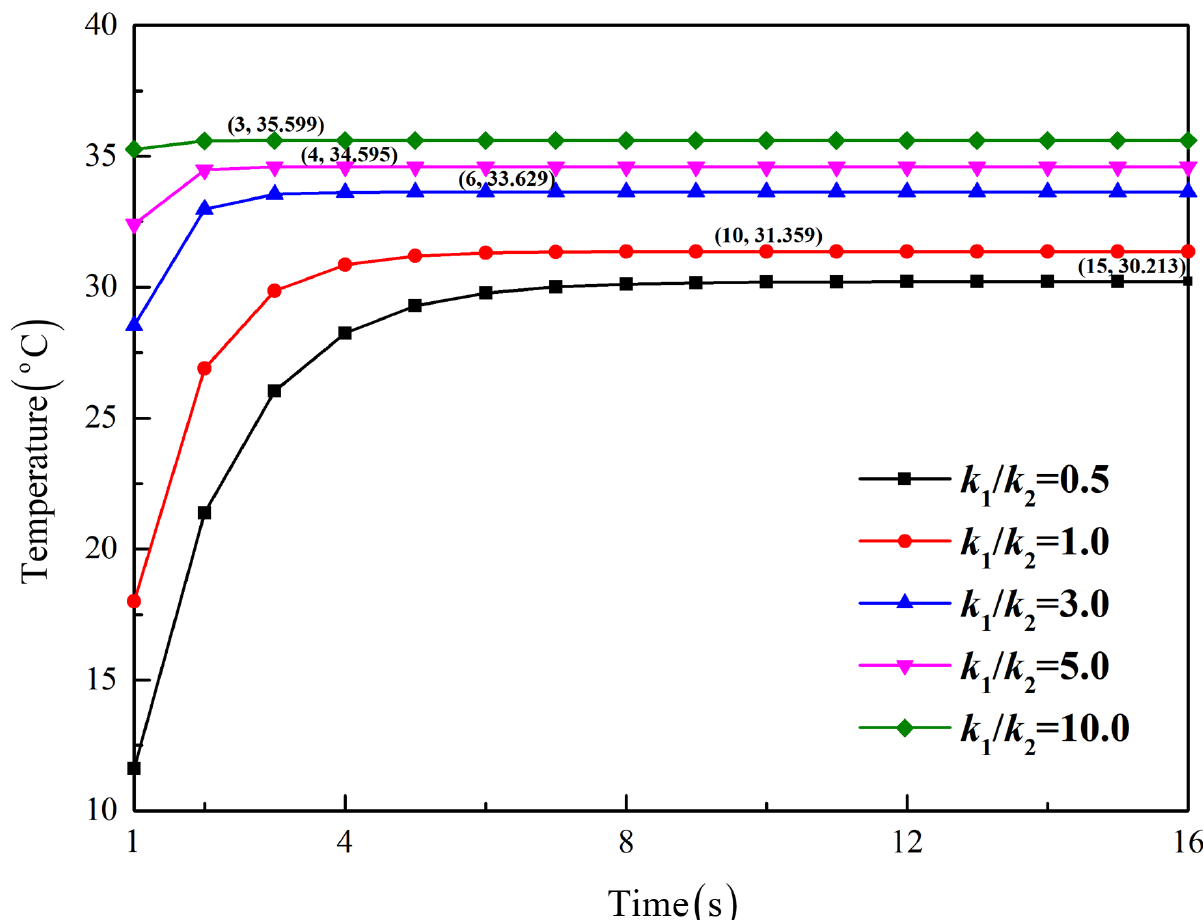
Figure 6. Influence of the thermal conductivity ratio on time-dependent temperatures for Case 1 at ( a /2, a /2).